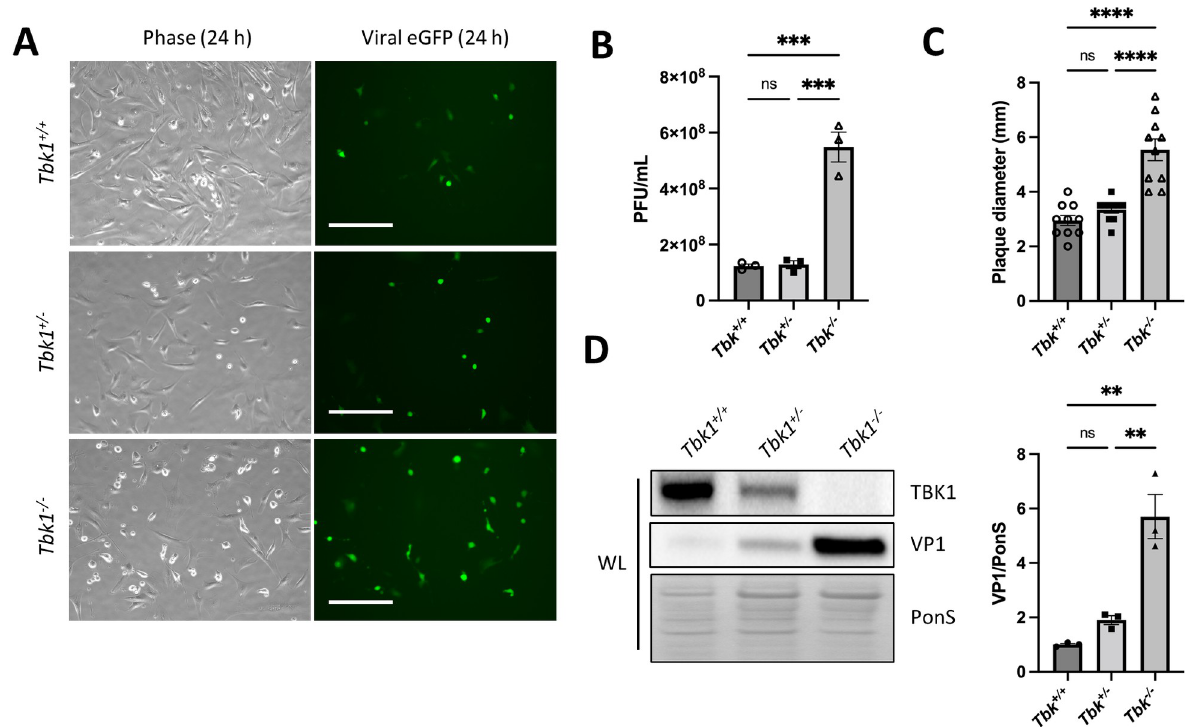
Fig 1. CVB infection increases in a genetic knockout of TBK1 . Wild-type ( TBK1 +/+ ), heterozygous knockout ( TBK1 +/- ), and homozygous knockout ( TBK1 -/- ), mouse embryonic fibroblasts (MEFs) were infected with eGFP-expressing coxsackievirus B at a multiplicity of infection of 10 (MOI 10). (A) Fluorescence microscopy of infected MEFs at 24 h post-infection (p.i.). Phase contrast images show similar cell density at 24 h p.i. Scale bars represent 100 μ m. (B) Extracellular viral titers of infected cells at 24 h as measured by plaque assay. ��� , p < 0.001. Student t test n = 3. (C) Diameter of viral plaques. ���� , p < 0.0001, Student t test; n = 10. (D) Western blots of infected cells at 24 h p.i. including densitometry. A representative Western blot is shown. �� , p < 0.01, Student t test; n = 3. Data are representative of 3 experiments. WL = whole lysate.